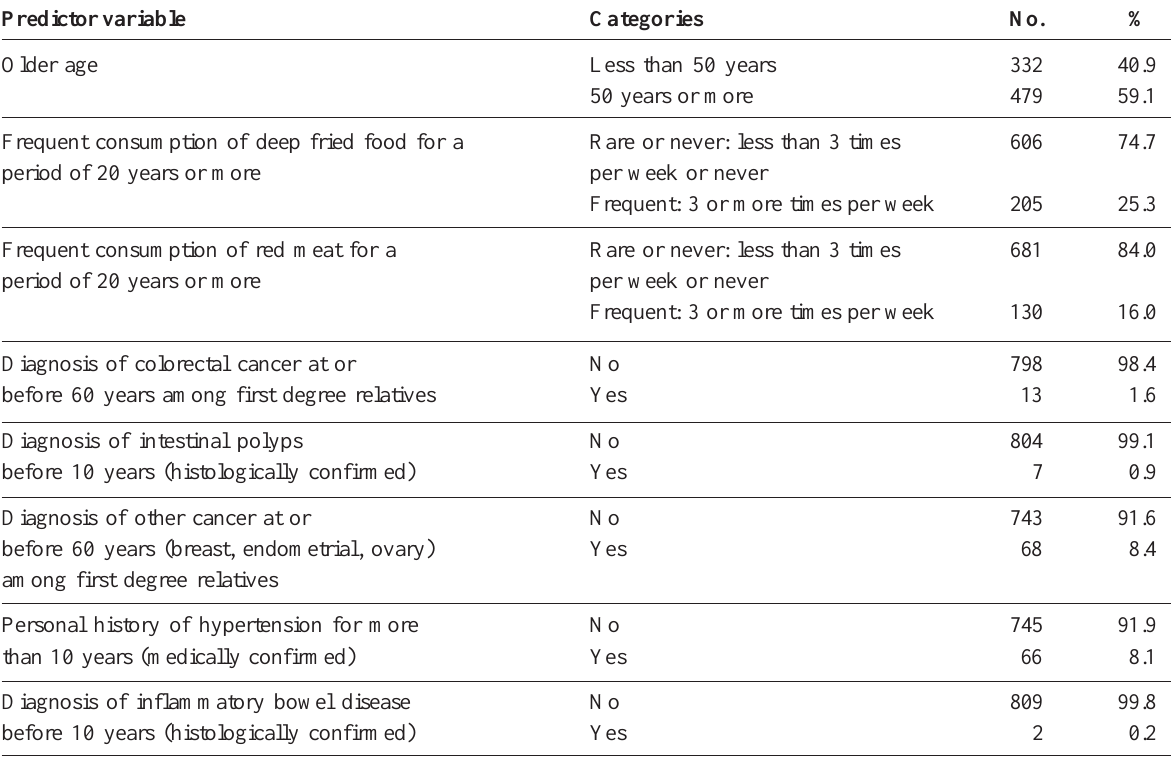
Table 3. Distribution of the study population by each predictor of the risk prediction model (N=811)